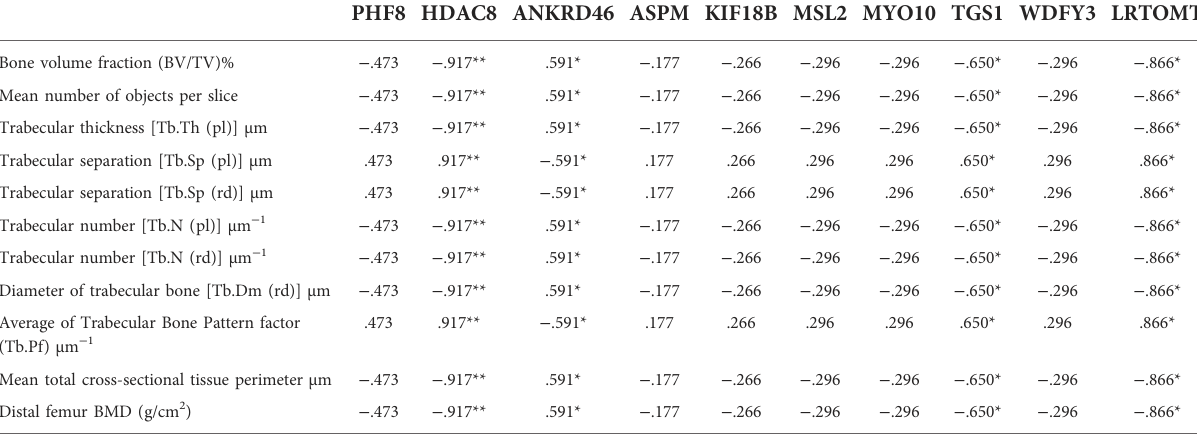
TABLE 2 Correlation analysis between Top 10 differential proteins of protein-protein interaction network and bone microstructure